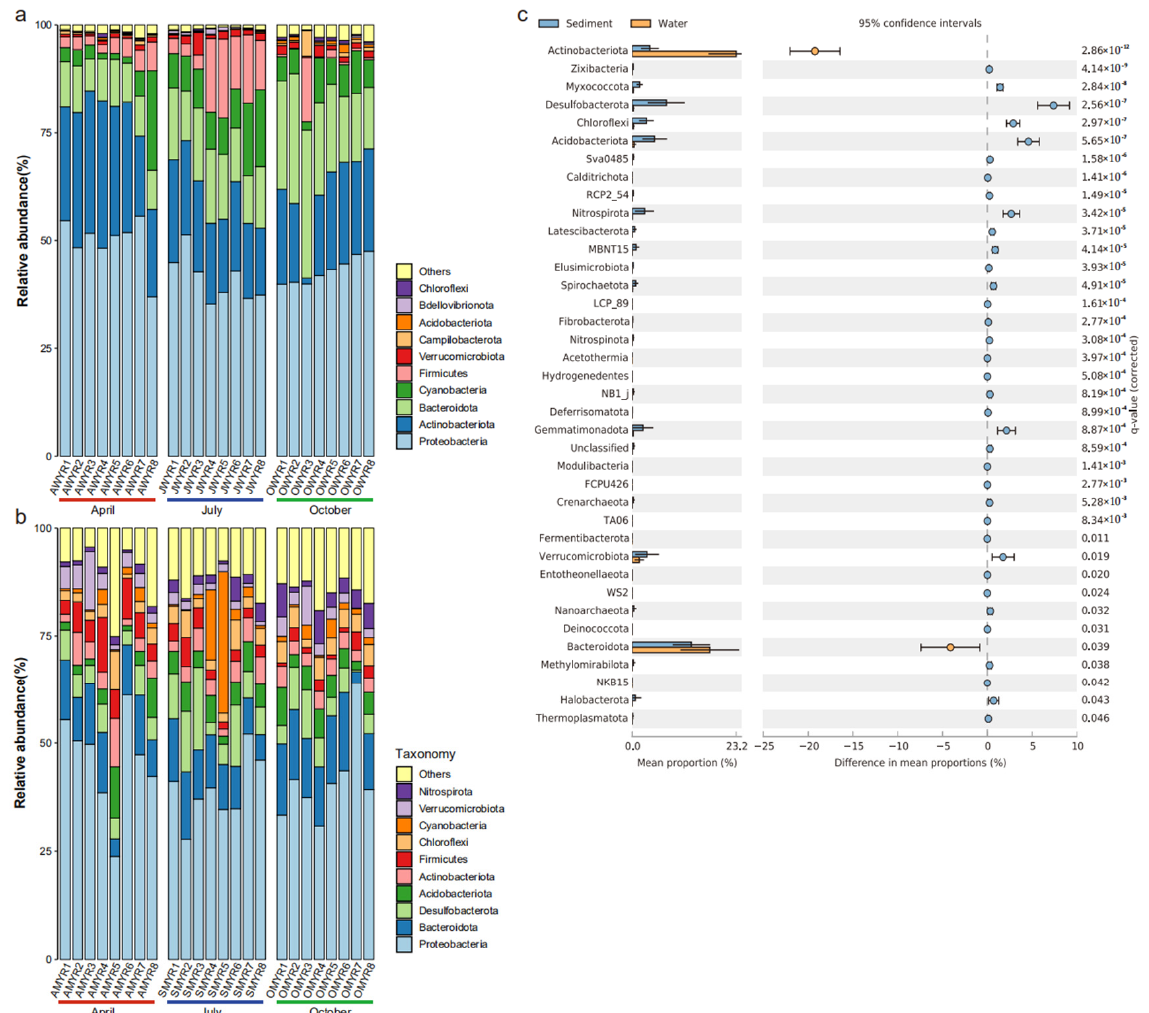
Figure 3. Relative abundances of the top 10 bacterial phyla in the two habitats (( a ) water; ( b ) sediment). The remaining phyla were defined as “other”. The extended error bar plot ( c ) shows multiple clades with differences in the two habitats. The left bar represents the number of ASVs in each clade, the middle is the 95% confidence interval, and the right is the corrected p -value.